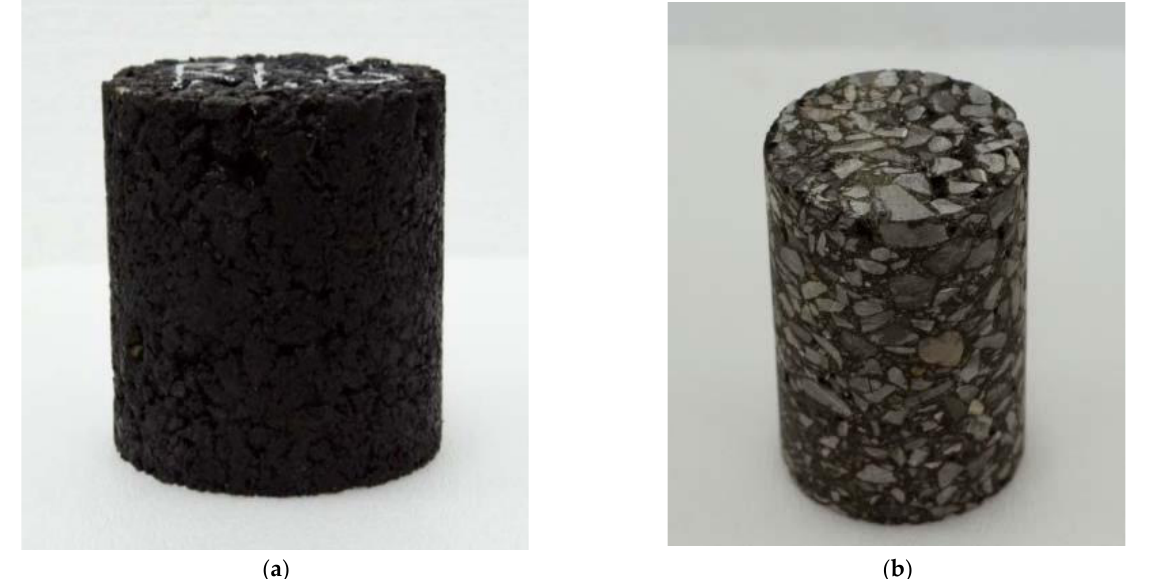
Figure 1. Asphalt mixture test piece: ( a ) raw specimen; ( b ) standard specimen.